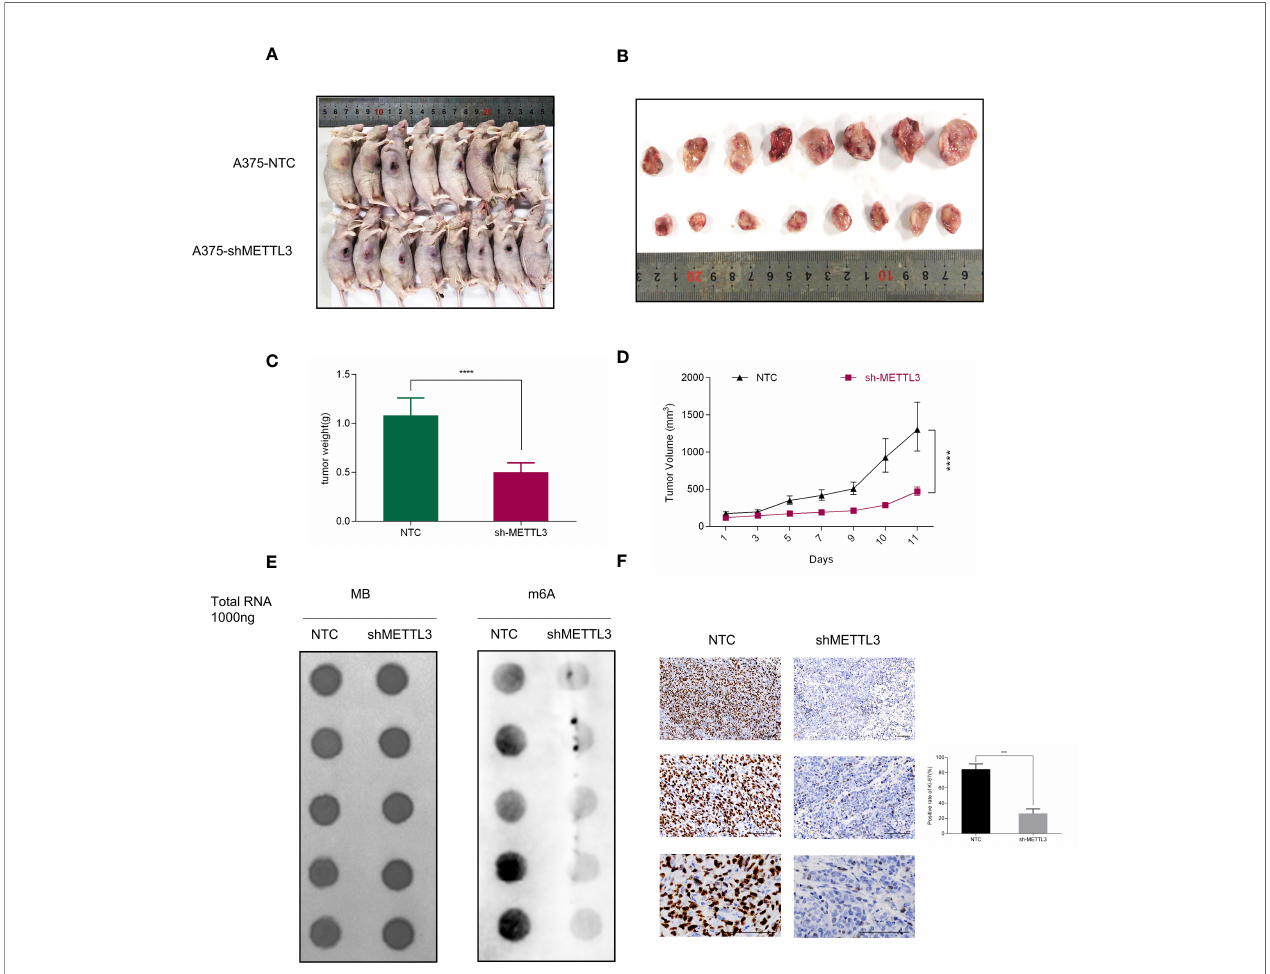
FIGURE 4 | METTL3 depletion delays tumor growth in nude mice. (A, B) Representative photographs and tumor size are shown at 11 days after inoculation. (C) Xenografts derived from A375-shMETTL3 cells demonstrated (C) tumor weight and (D) volume that were much lower than their A375 NTC cell-derived counterparts. (E) m 6 A level of METLL3 knockdown group xenografts was much lower than in control tumors. (F) Representative Ki 6 7 staining of xenograft tumor section and quanti fi cation of Ki 6 7-positive cells are shown. Bar = 100 m m. Data are presented as the mean ± SD (n = 5). Signi fi cant differences were evaluated using Student t-test. ***P < 0.001, ****P <